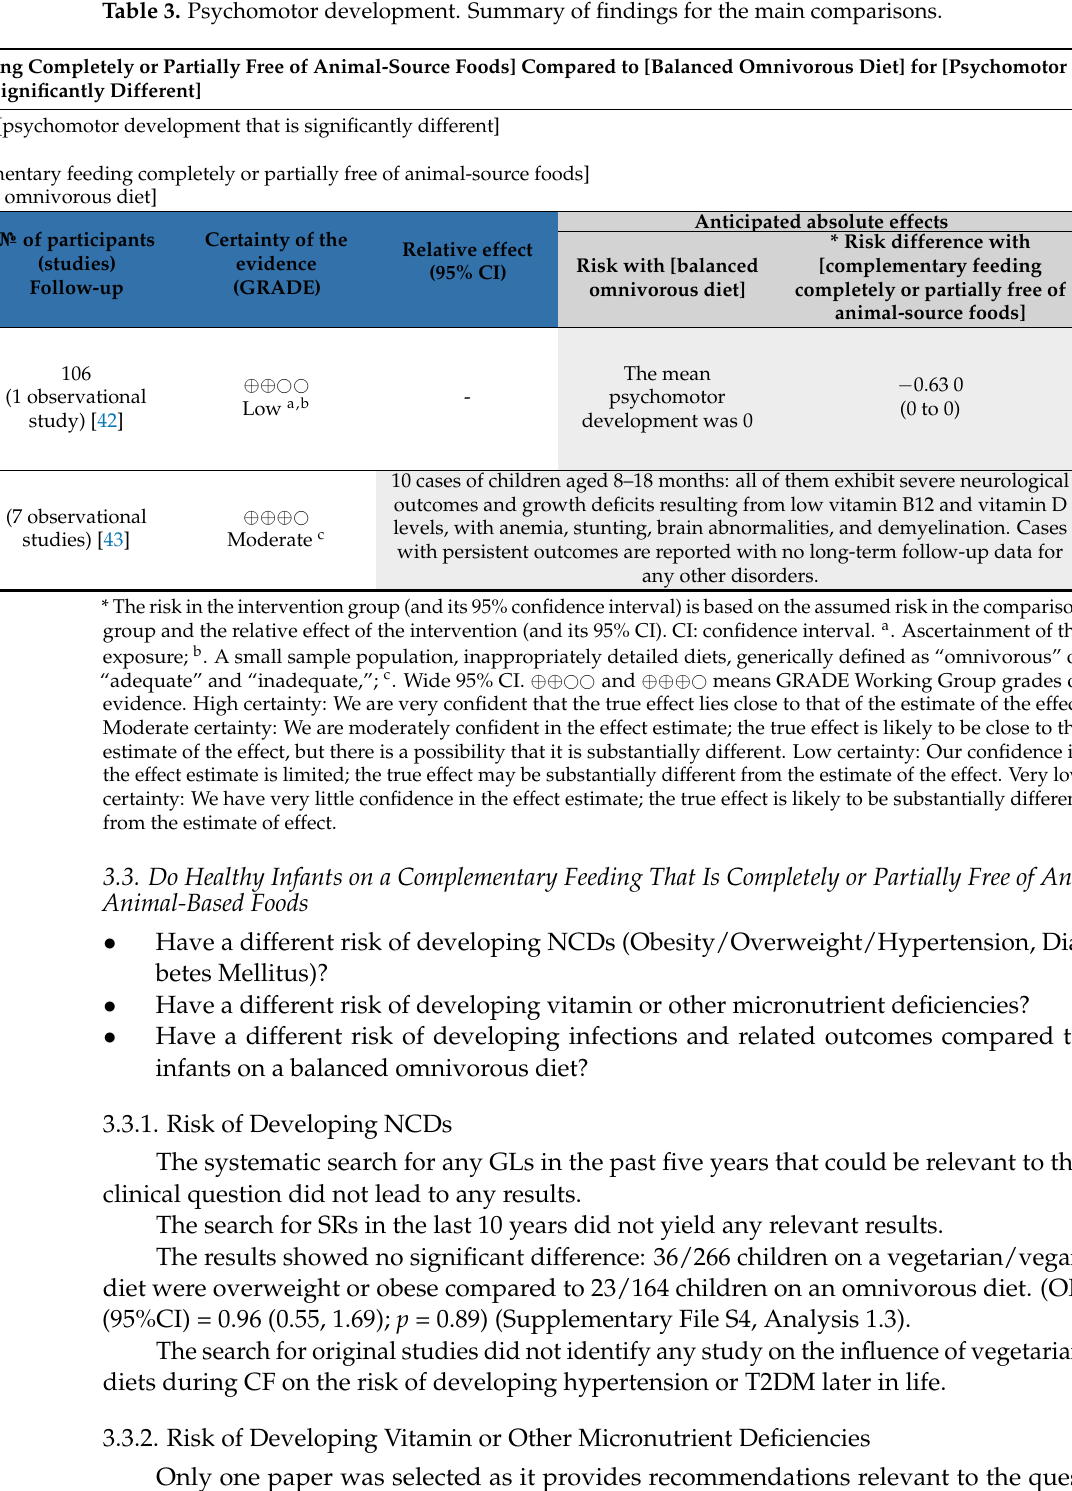
Table 3. Psychomotor development. Summary of findings for the main